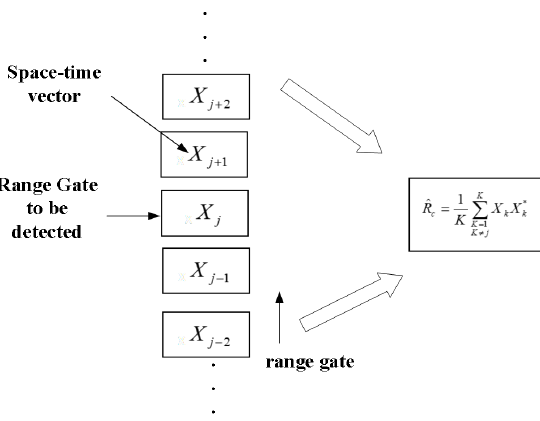
Figure 8. Clutter covariance matrix estimation.